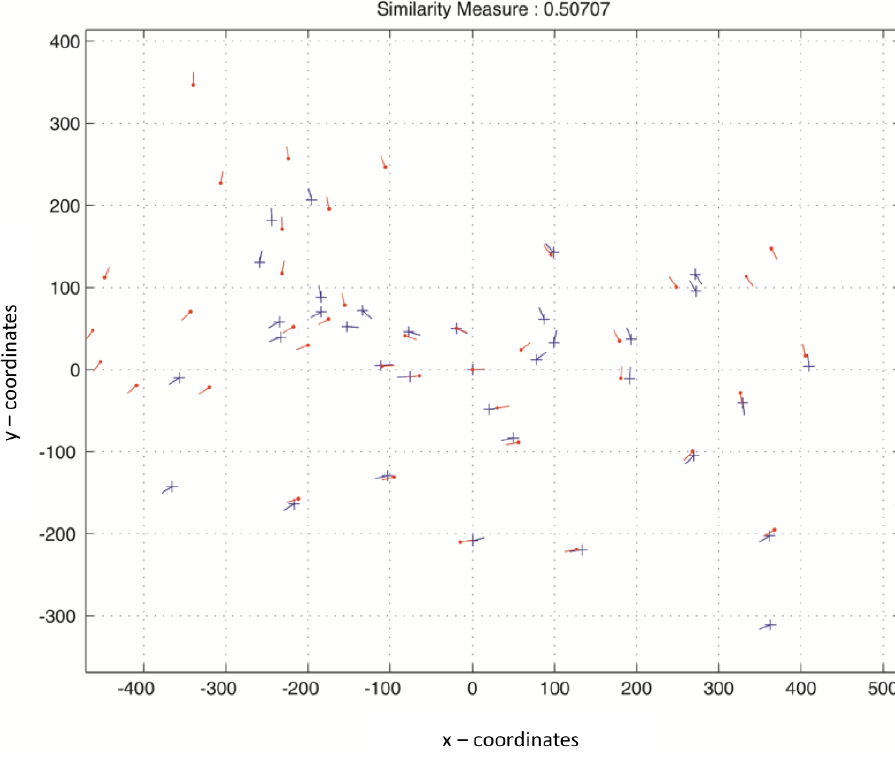
Figure 8. Matching score between two transformed fingerprint templates of the same user in the same